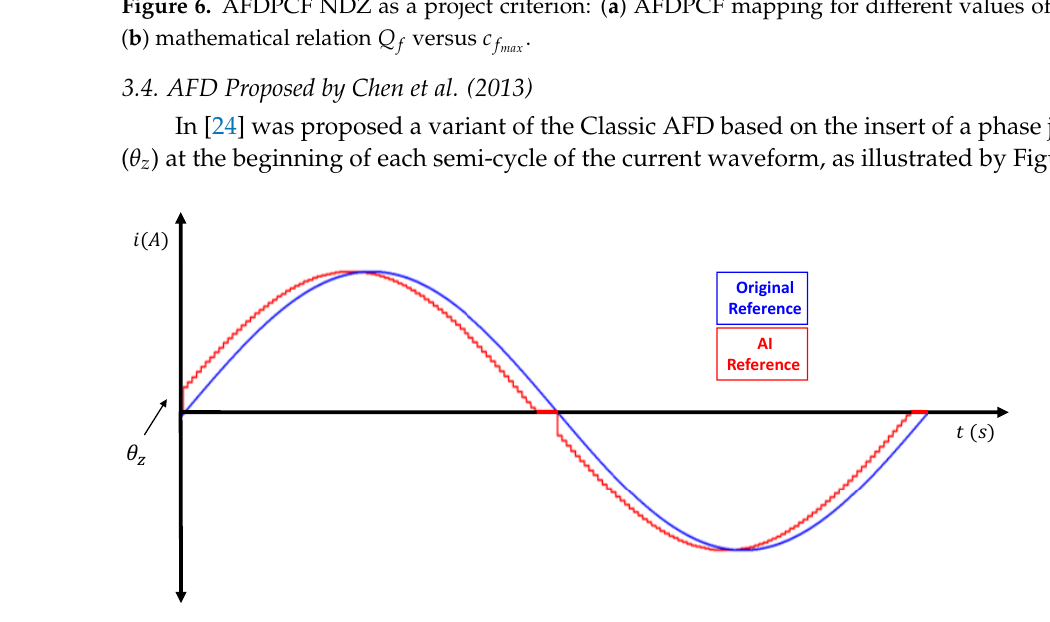
; ( b ) 𝑓 𝑚𝑎𝑥 ; ( b ) ; 𝑚𝑎𝑥 max